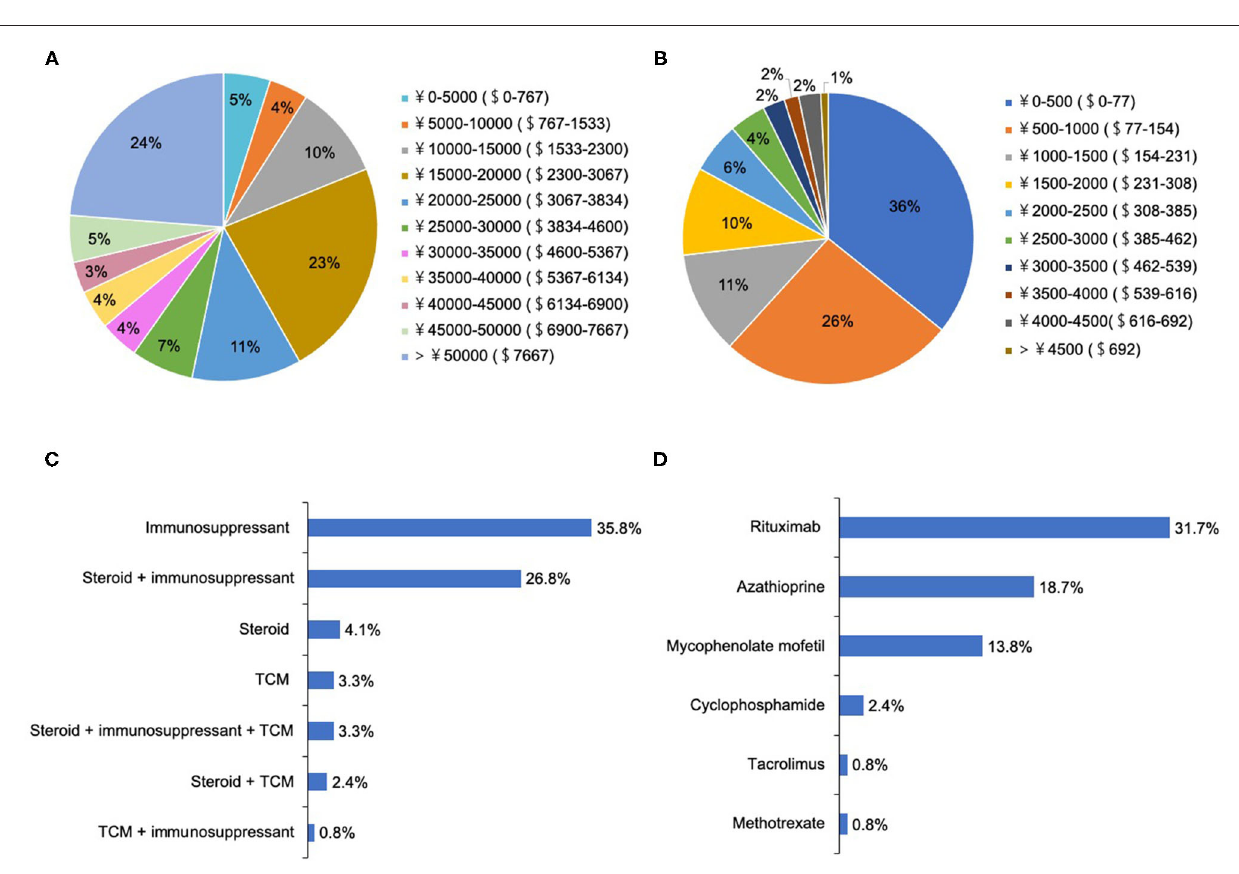
FIGURE 3 | The treatment selections and expenditure for patients with NMOSD. (A) The hospitalization expenditure per recurrence ( È , CNY; $, USD). (B) The medical expenditure in the remission phase per month ( È , CNY; $, USD). (C) The medical selections in the remission phase. (D) The choices of immunosuppressants in the remission